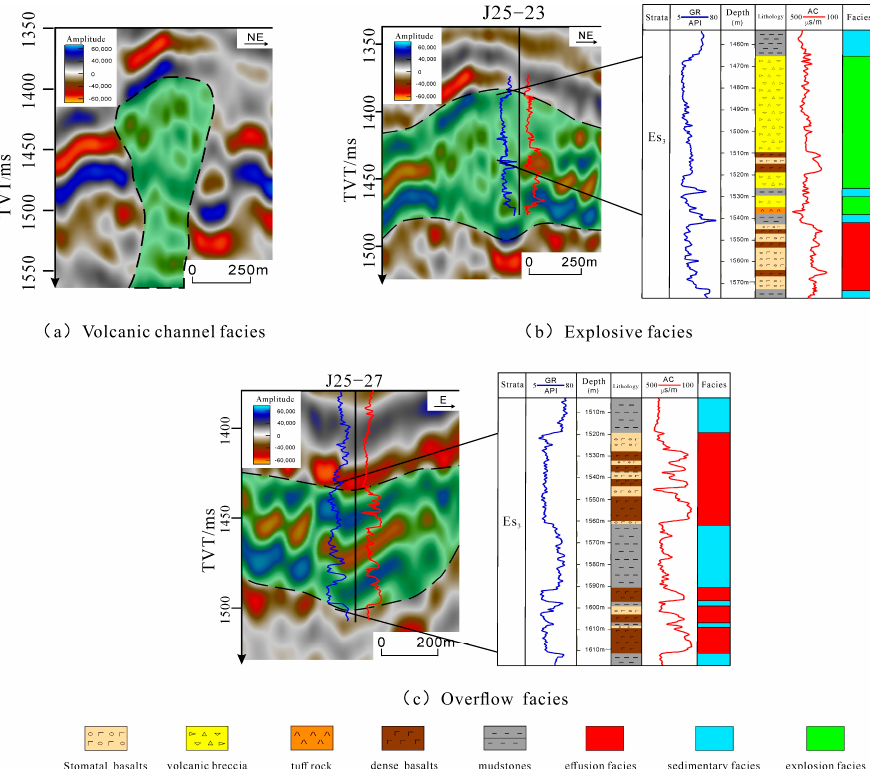
Figure 4. Seismic facies and logging facies characteristics of different lithofacies of the third member of the Shahejie formation. ( a ) volcanic channel facies; ( b ) explosive facies; ( c ) overflow facies. Huanghua depression is in a strong fault depression period during the sedimentation period of the third member of the Shahejie formation. The volcanic activity of the Zao35 fault block experienced a quiet fissure overflow—intermittent effusion—multi center fissure eruption. According to the characteristics of seismic data, it is determined that there are two kinds of eruption channels for the magma in this area. The volcanic rocks in the third member of Shahejie formation of the Zao35 fault block are divided into fissure type eruption and central type eruption. Three central volcanic channels are mainly developed in the Zao35 fault block. The seismic reflection event axis is shown as weak amplitude reflection, in the form of upward divergent umbrella shaped and nearly vertical columnar, distributed parallel to the strike of the fault zone, and the scale is one large and two small (Figure 5).